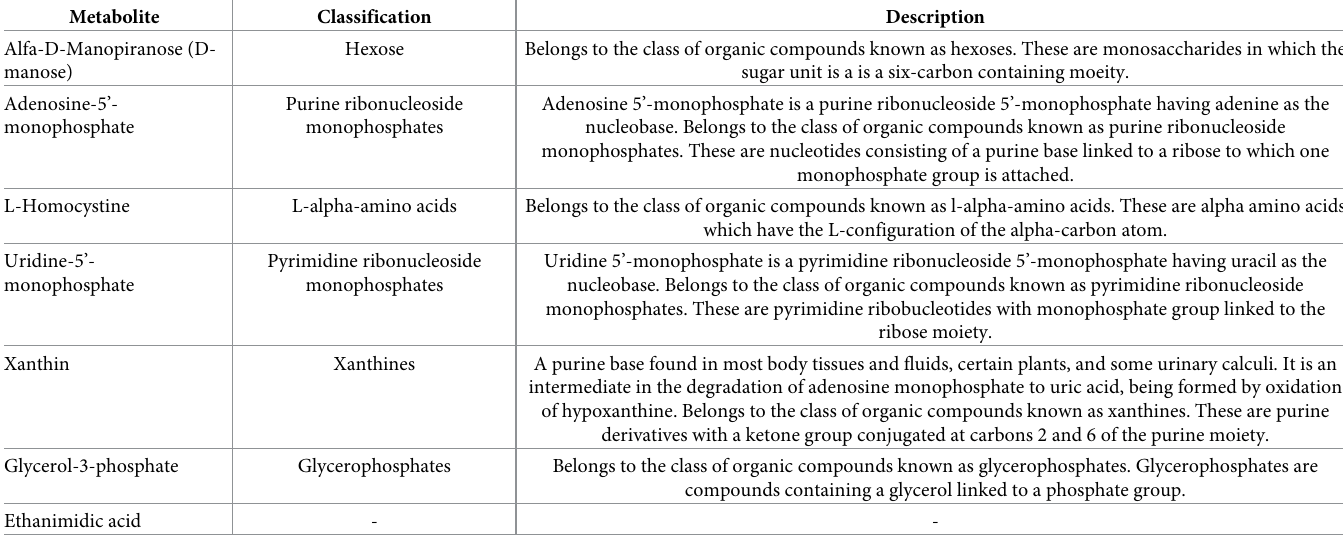
Table 2. Classification of the metabolites identified in the consortium through GC-MS.